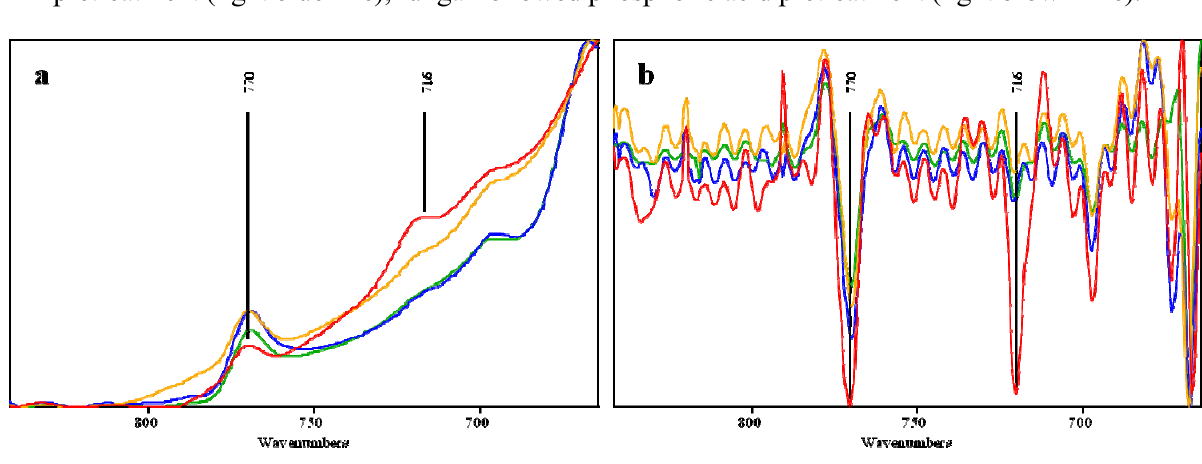
Figure 3. FTIR spectra ( a ) and second derivative spectra ( b ) at wavenumber 770 cm − 1 vibration in cellulose I ) and 716 cm − 1 (CH vibration in cellulose I ). Lines (CH 2 α 2  assignment were: untreated (red line), fungal pretreatment (green line), phosphoric acid pretreatment (light blue line), fungal followed phosphoric acid pretreatment (light brown